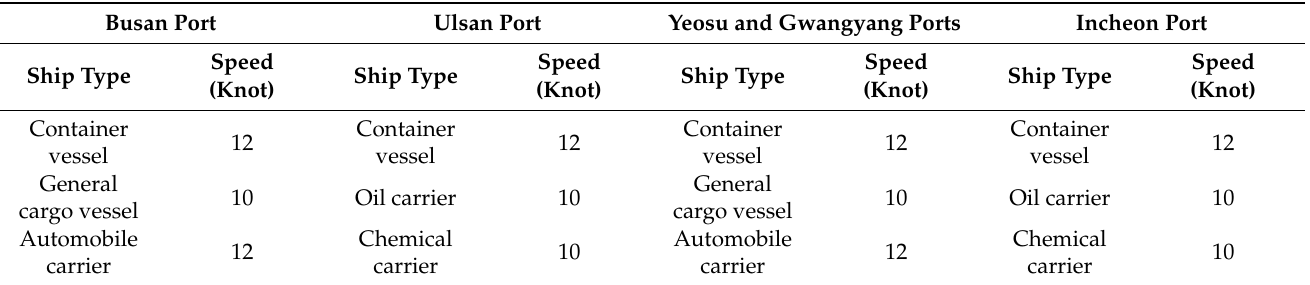
Table 1. Target vessel type and recommended